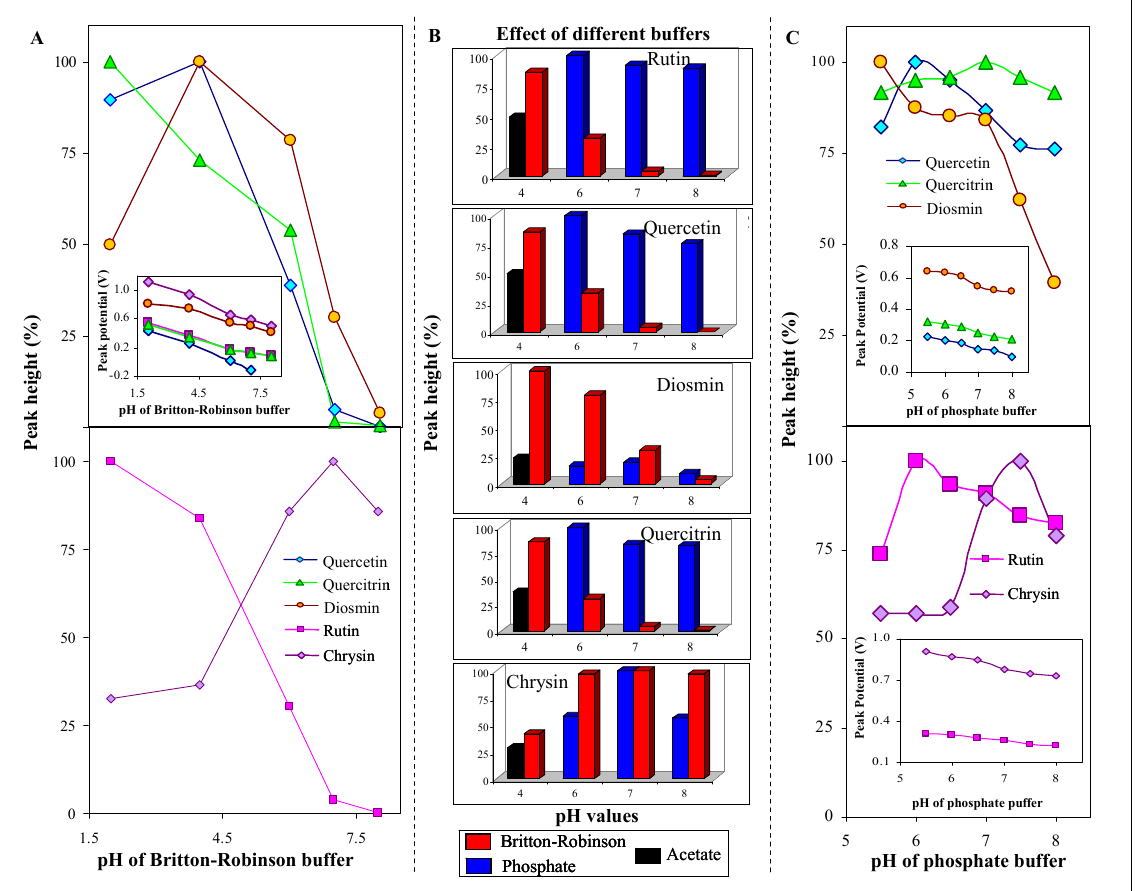
Figure 4. Influence of pH of Britton-Robinson buffer on peak heights and potentials of the flavonoids ( A ). Comparison of peak heights of the flavonoids measured in different buffers ( B ). Dependencies of peak heights and potentials of the flavonoids on different pH values of phosphate buffer ( C ). Square wave voltammetric parameters were as follows: step potential 1.95 mV, and frequency 180 Hz. For other details see Figure